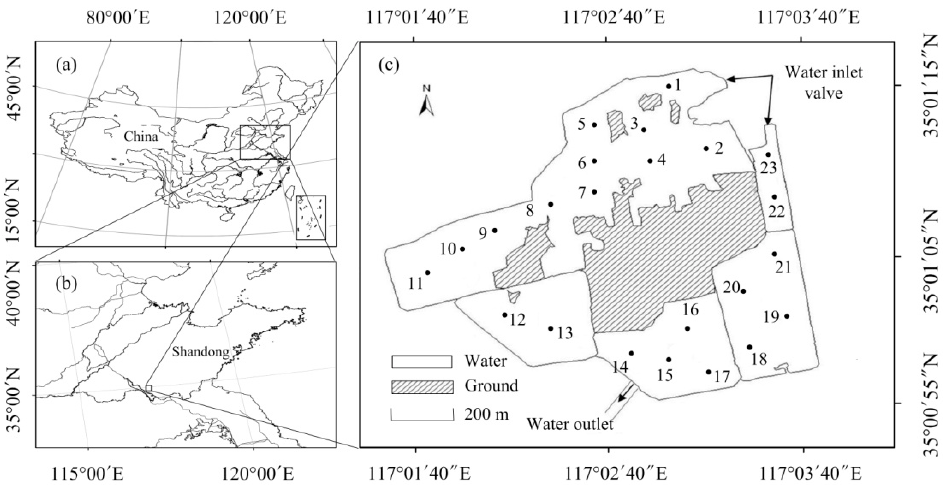
Figure 1. Location of Lake Qixinghu in ( a ) China; and ( b ) Shandong Province; and ( c ) the sample sites in the lake.